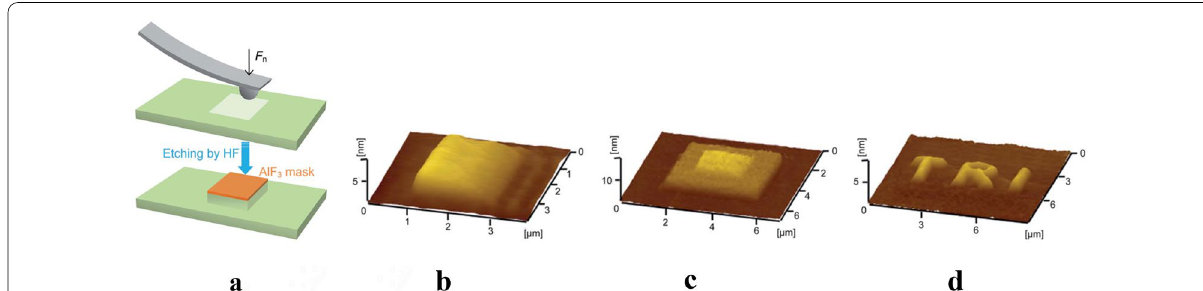
Figure 23 Friction-induced selective etching on glass surface [84]: ( a ) schematic diagram showing the fabrication process, ( b ) ‒ ( d ) an inclined surface, hierarchical stages, and “TRI” pattern fabricated on glass